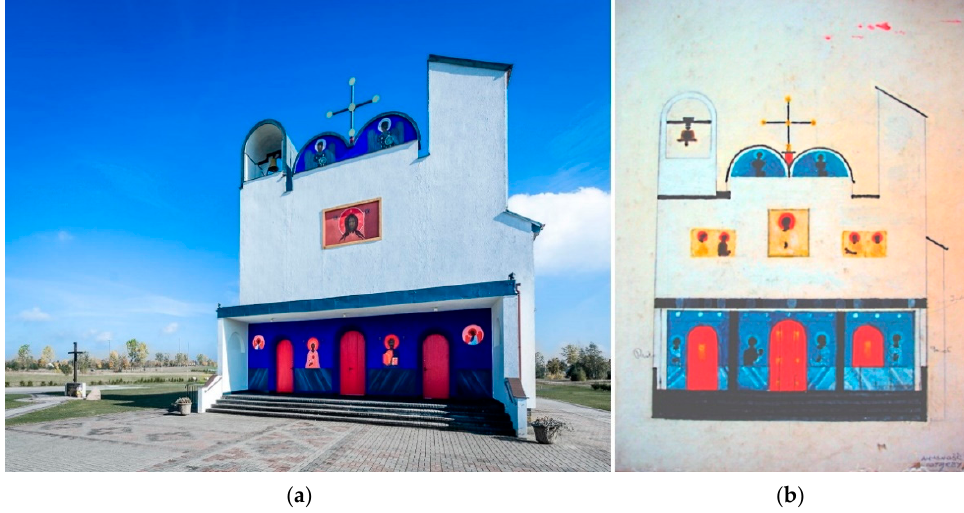
Figure 14. Greek Catholic church in Bia ł y Bór. ( a ) View of the façade. Photography by Arek Łuszczyk. ( b ) Jerzy Nowosielski, Early design sketch of the façade Photography by M. Gardulski/Galeria Starmach. Reproduced with permission.